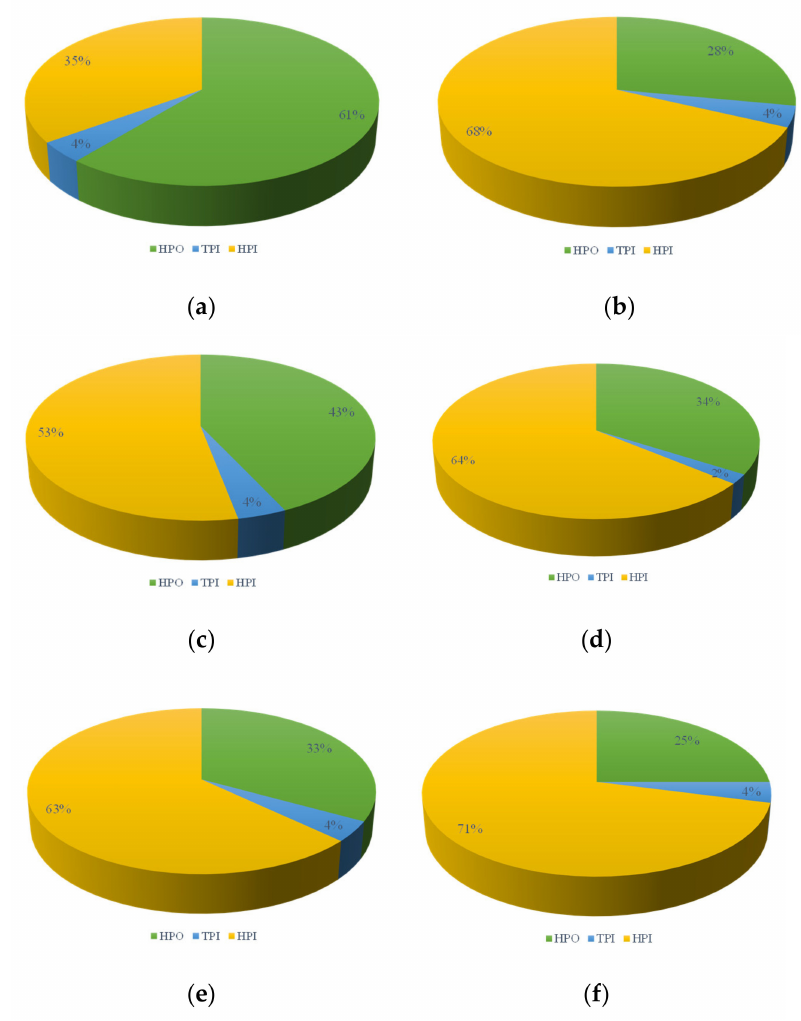
Figure 8. Proportion of hydrophilic and hydrophobic components: ( a ) direct UF filtration, alkaline cleaning; ( b ) direct UF filtration, acid cleaning; ( c ) L-UF, alkaline cleaning; ( d ) L-UF, acid cleaning; ( e ) S-UF, alkaline cleaning; ( f ) S-UF, acid